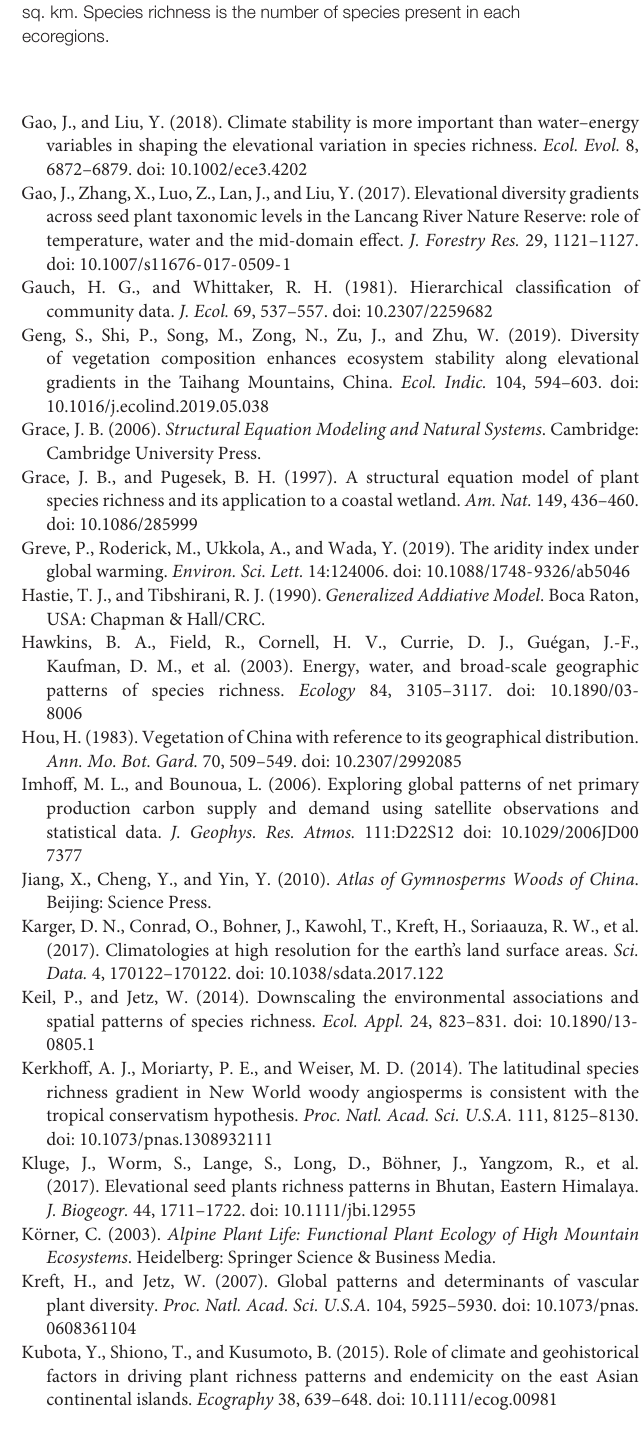
euclidean values of similarities. The red color box indicates the group of similar ecoregions. Supplementary Table 1 | The ecoregions of China with the geographic code assigned in this study, names of eco-regions, and the characteristics forest types each region. The elevation range represents the lower and higher elevation bands of respective ecoregions expressed in meter (above sea level). Area is the total surface coverage of terrestrial land expressed in sq. km. Species richness is the number of species present in each